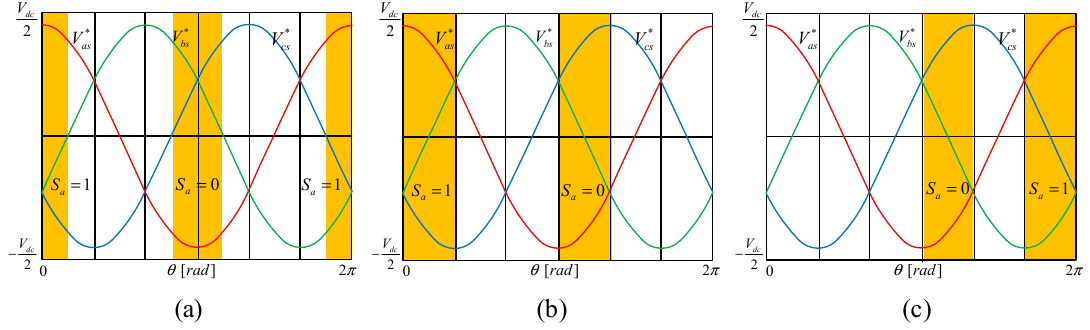
Figure 3. The 60 ◦ discontinuous PWM technique: ( a ) 60 ◦ DPWM; ( b ) 60 ◦ (+30 ◦ ) DPWM; ( c ) 60 ◦ Figure 3. The 60 ° discontinuous PWM technique: ( a ) 60 ° DPWM; ( b ) 60 ° (+ 30 °) DPWM; ( c ) 60 ° (− 30 °) ( − 30 ◦ ) DPWM.